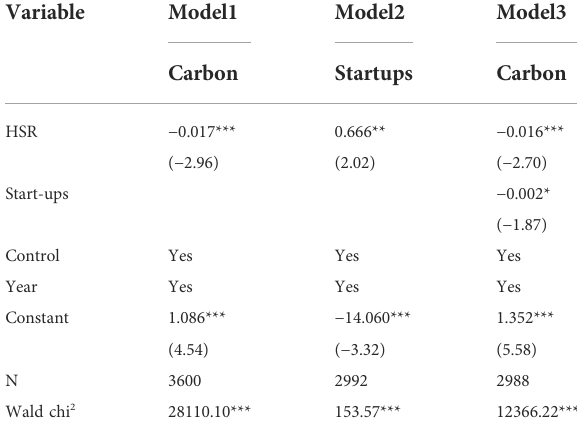
TABLE 4 Baseline regression. TABLE 5 The mediating effect of